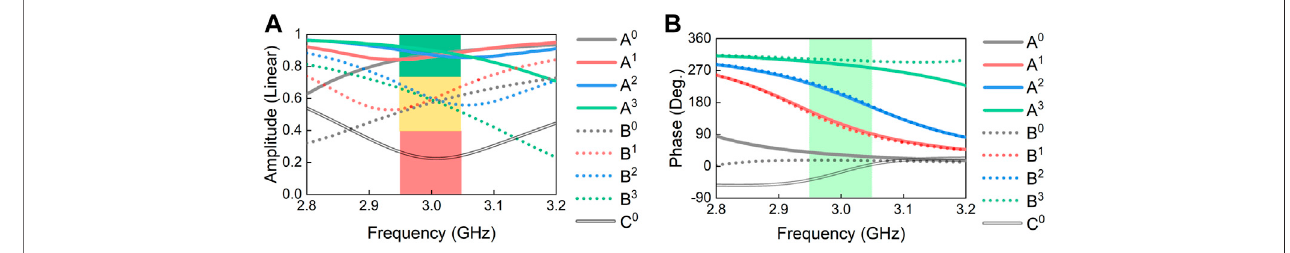
FIGURE 4 | Numerical simulation results for the (A) amplitude and (B) phase responses of the programmable element. “ A 0 A 1 A 2 A 3 B 0 B 1 B 2 B 3 C 0 ” is de fi ned as nine coding states with different re fl ection amplitude and phase.